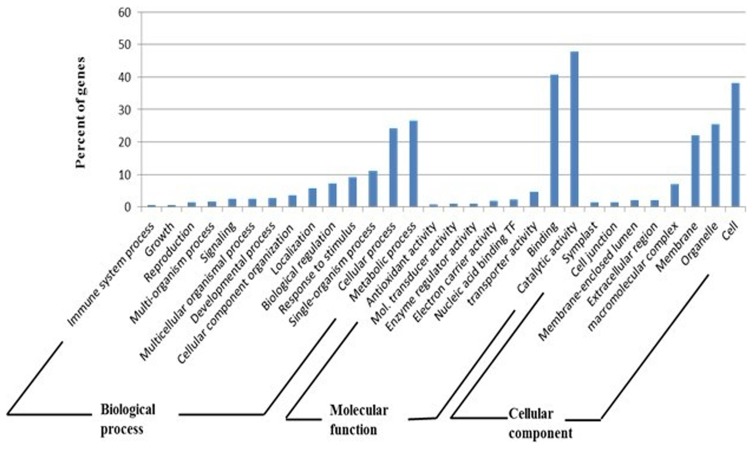
Gene Ontology (GO) of significantly changed Citrullus colocynthis genes under drought stress.Based on high-score BLASTX matches in the NR (non-redundant) plant protein database, C. colocynthis genes were classified into three main GO categories. The y-axis indicates the percentage of a specific category of genes in each main category.